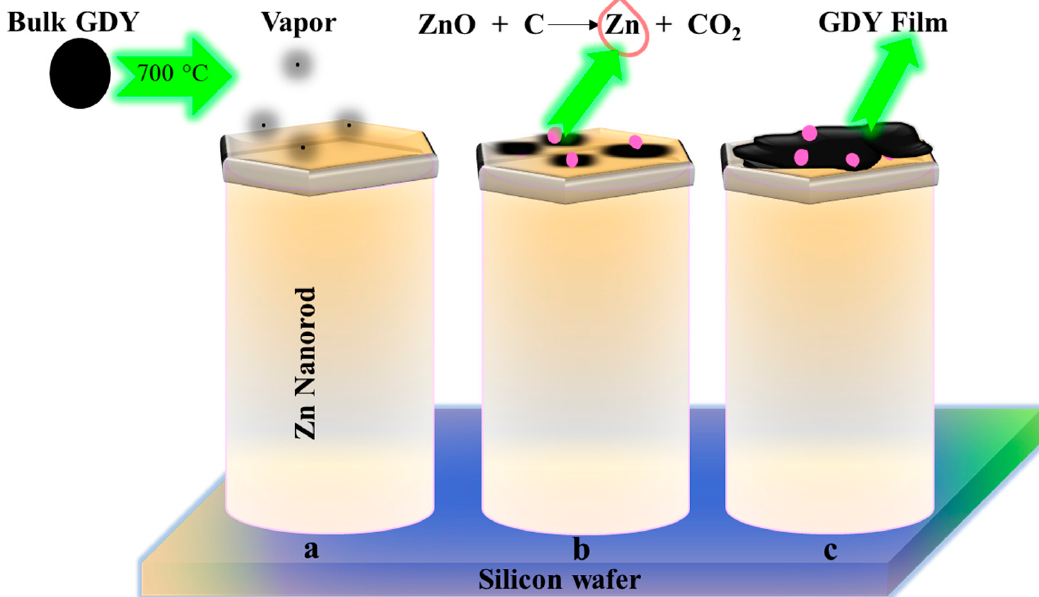
Figure 4. The illustration of the increase in a GDY layer in the VLS process on the head of a single ZnO NR ( a ) ZnO NRs in the presence of GDY vapors, ( b ) Zn droplet on the head of the ZnO NRs, and ( c ) Zn droplets scattered in GDY thin film, produced by connected several neighboring flakes of GDY. Redrawn [62].